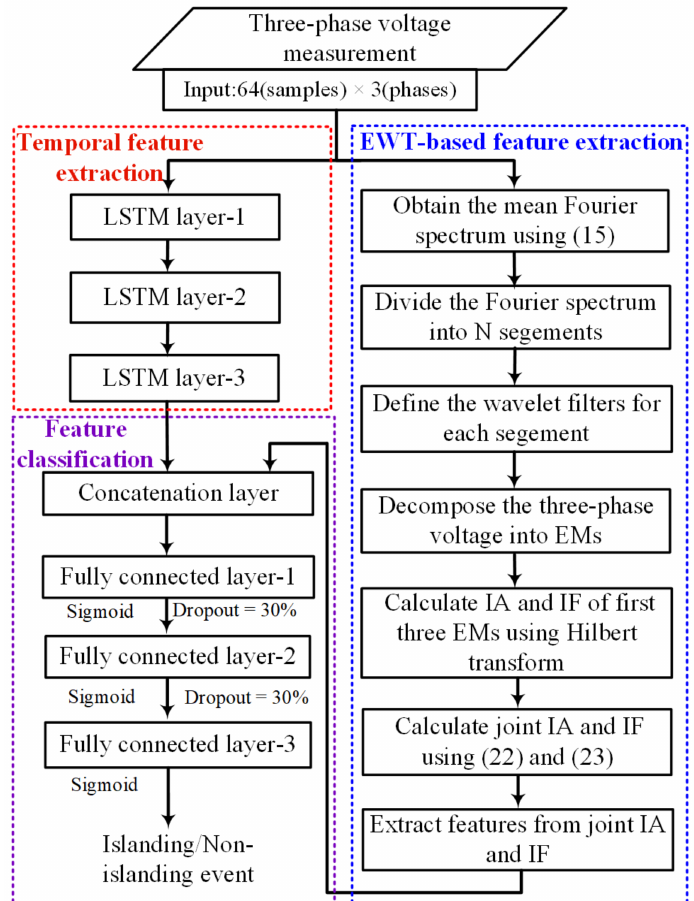
Figure 3. Flow chart of the proposed